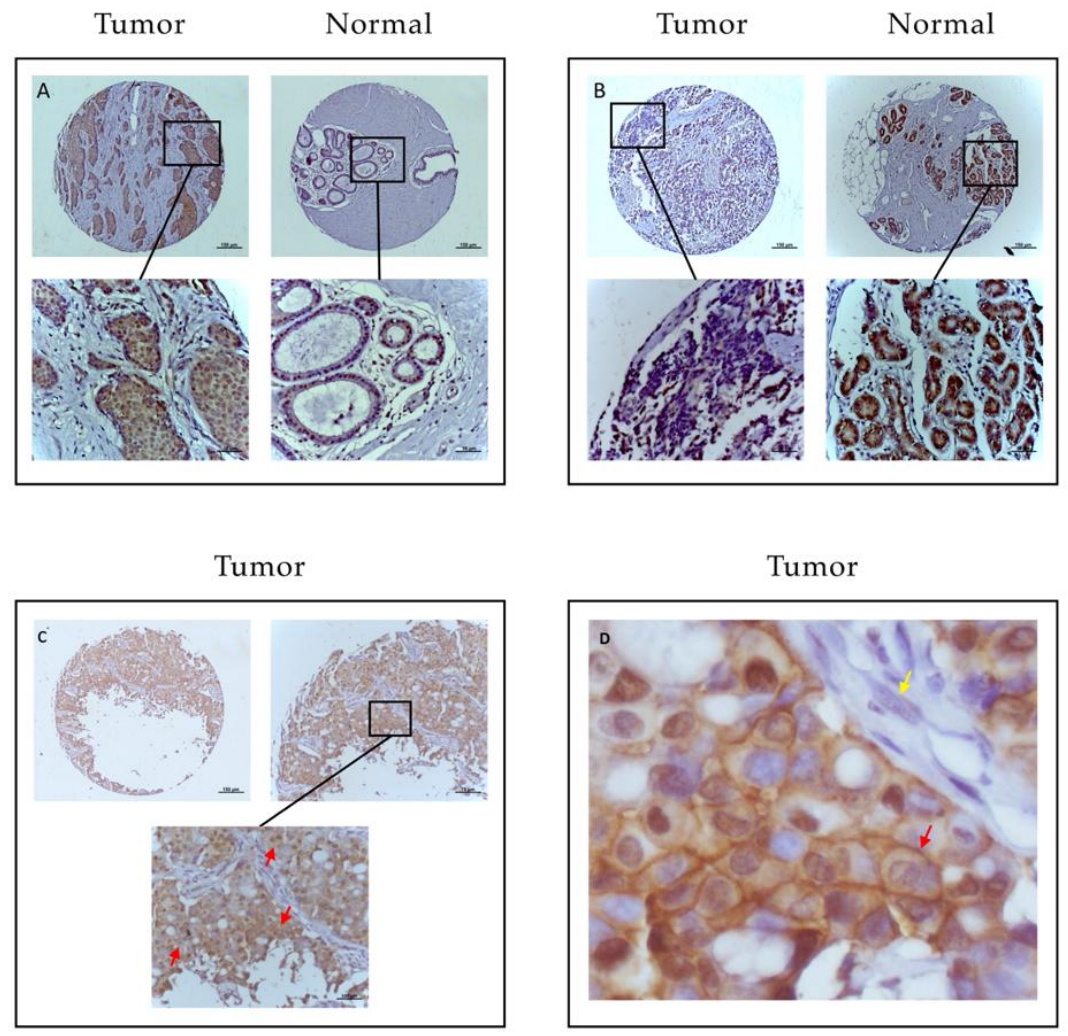
Figure 1. Examples of staining pattern for EphB4 in tumor and normal tissue sets from patients with breast cancer. ( A ) shows the common staining pattern with higher expression of EphB4 in tumor tissue comparing to corresponding normal tissue. ( B ) shows an aberrant pattern with higher expression of EphB4 in normal tissue than staining in tumor tissue. The scale bars represent 100 micrometers at pictures above. Pictures below show 40 × enlargements of the sections in ( A – C ). ( D ) shows 400 × enlargement of a tumor section from panel ( C ) to emphasize membranous staining of EphB4. Red arrows indicate membrane staining, yellow arrow absence of EphB4 in stromal cells.